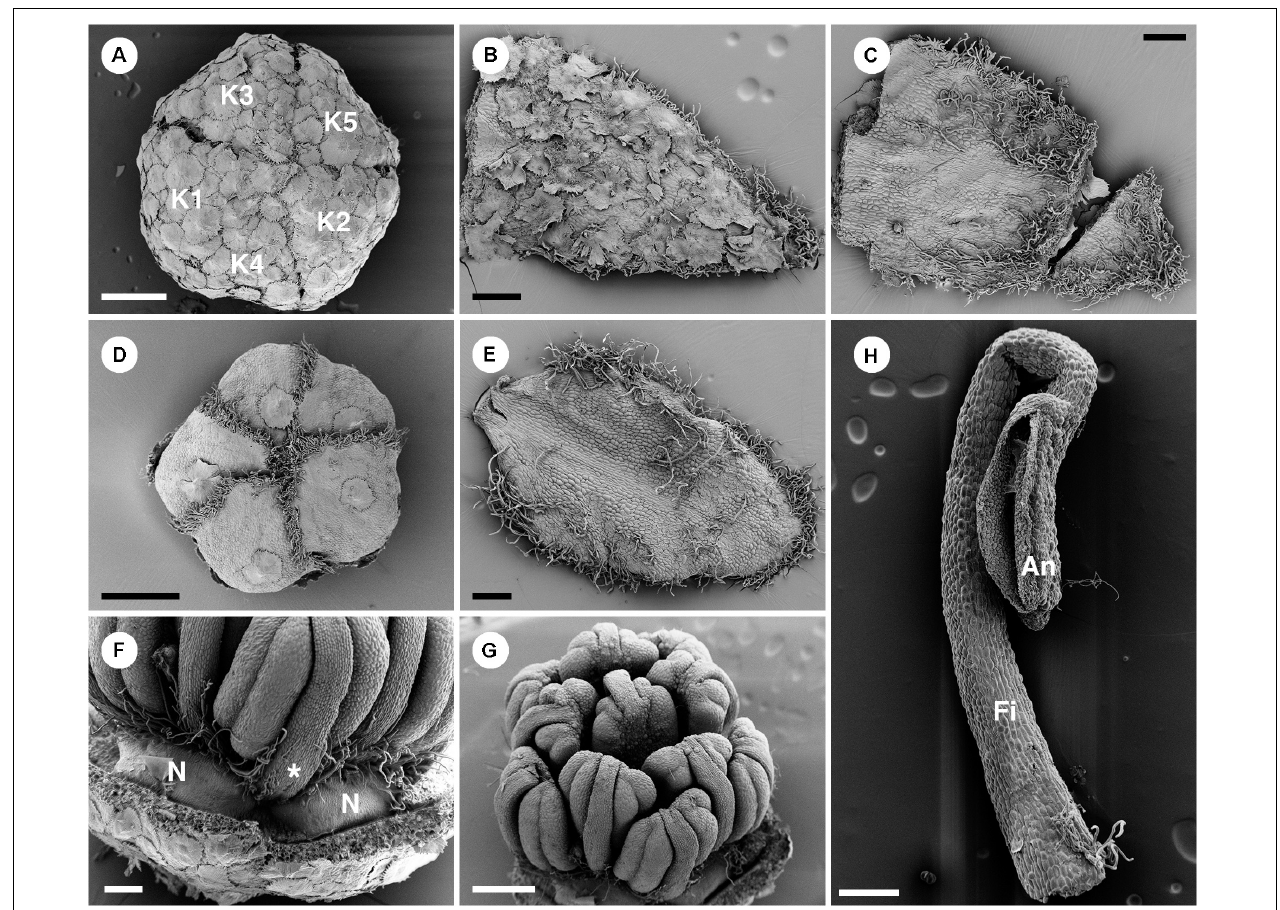
FIGURE 10 | Morphology of staminate flowers of Croton schiedeanus . (A) Calyx in flower bud with quincuncial aestivation. The surface is covered with lepidote trichomes. (B) Abaxial surface of a sepal with lepidote trichomes. (C) Adaxial surface of a sepal with many simple trichomes on the margin and apex. (D) Corolla in a flower bud with cochlear aestivation. There is a lepidote trichome visible on each petal. Note the frimbriate margin of petals. (E) Adaxail side of a sepal with few simple trichomes on the surface. There are many simple trichomes lining the margin and apex. (F) Nectaries located in alternation with petals and outermost stamens (asterisk). (G) There are 11 stamens arranged in two whorls surrounding a central stamen. The outermost stamens are arranged opposite petals. Note, stamens are inflexed in a flower bud. (H) A stamen with a stellate trichome on the base of the filament. K, sepal; N, nectary; Fi, filament; An, anther. Scale bars: (A,D,G) = 500 µ m; (B,C,E,F,H) = 200 µ